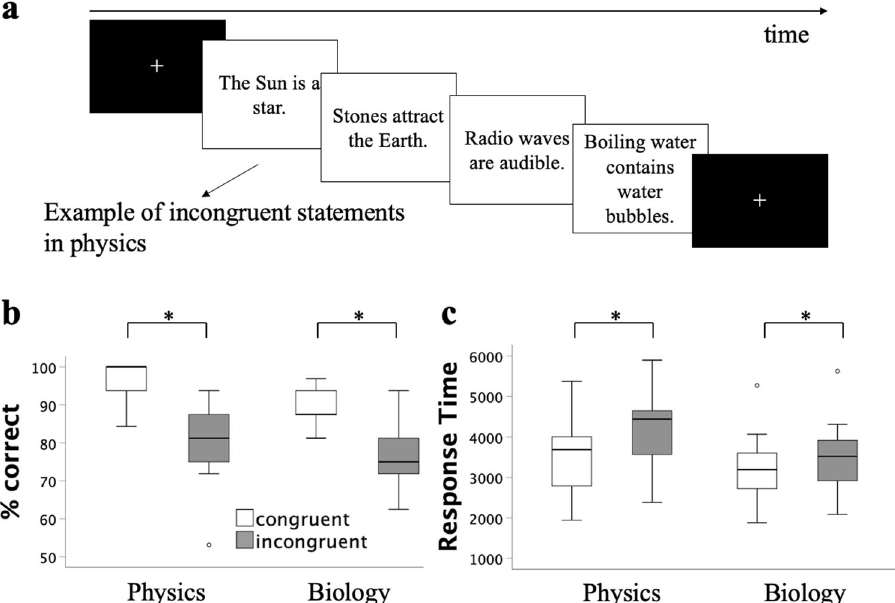
Fig. 1 Behavioral results. a On each trial, participants were presented with a written statement and judged it as scienti fi cally correct or incorrect. b Performance in this task (% correct). c Mean response time in this task (ms). Center line represents median; box limits, upper and lower box limits represent quartile 1 and quartile 3; whiskers represent minimum and maximum values; ° represents potential outliers ± 1.5× IQR (interquartile range). * p <